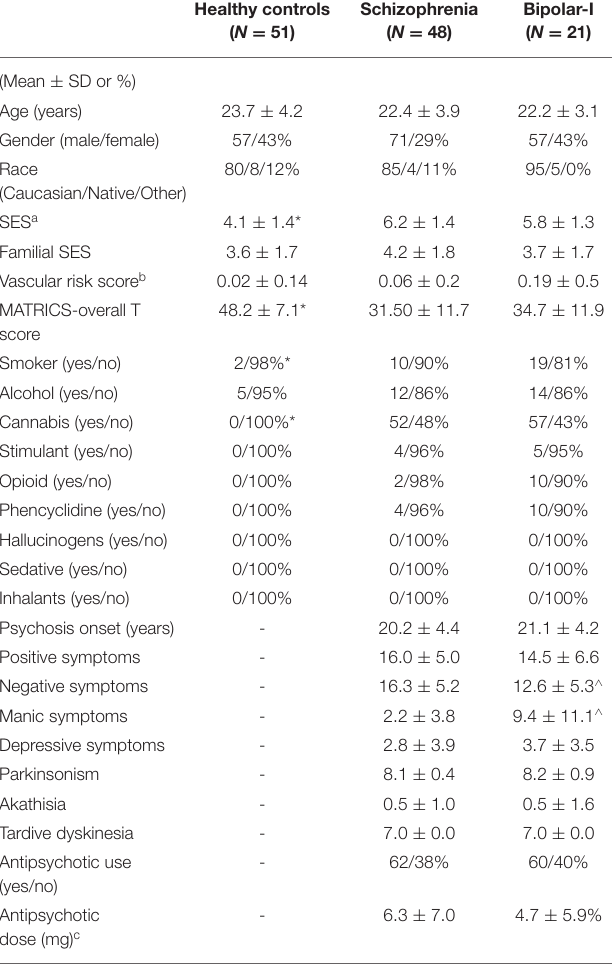
TABLE 1 | Demographic and clinical characteristics.